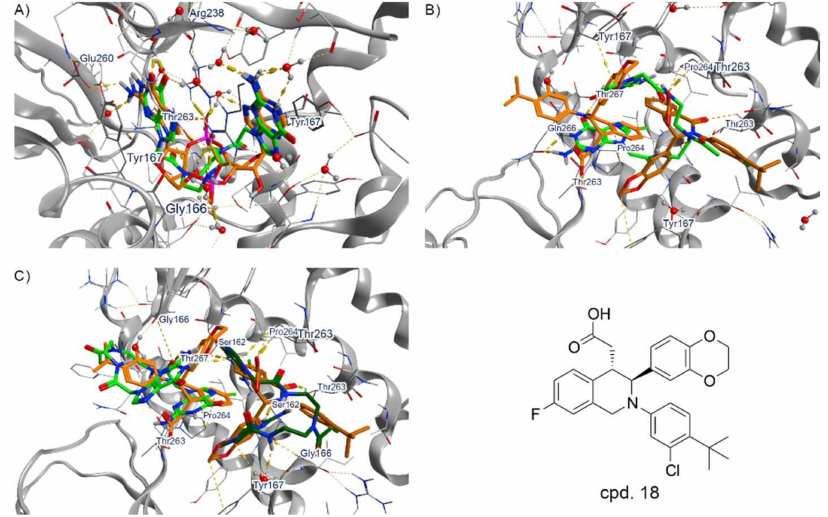
Figure 4. Docking study of 7 and 12 within the ligand binding site of STING (PDB ID: 4LOH for 7 , 6MXE for 12 ) using MOE. ( A ) The 3D-structure of superposed docked conformation of 7 (green) with the natural ligand, cGAMP (orange). ( B ) The 3D-structure of superposed docked conformation of a single molecule of 12 (green) with a reference inhibitor, cpd. 18 (orange). ( C ) The 3D-structure of superposed docked conformations of two molecules of 12 (green) with inhibitor 18